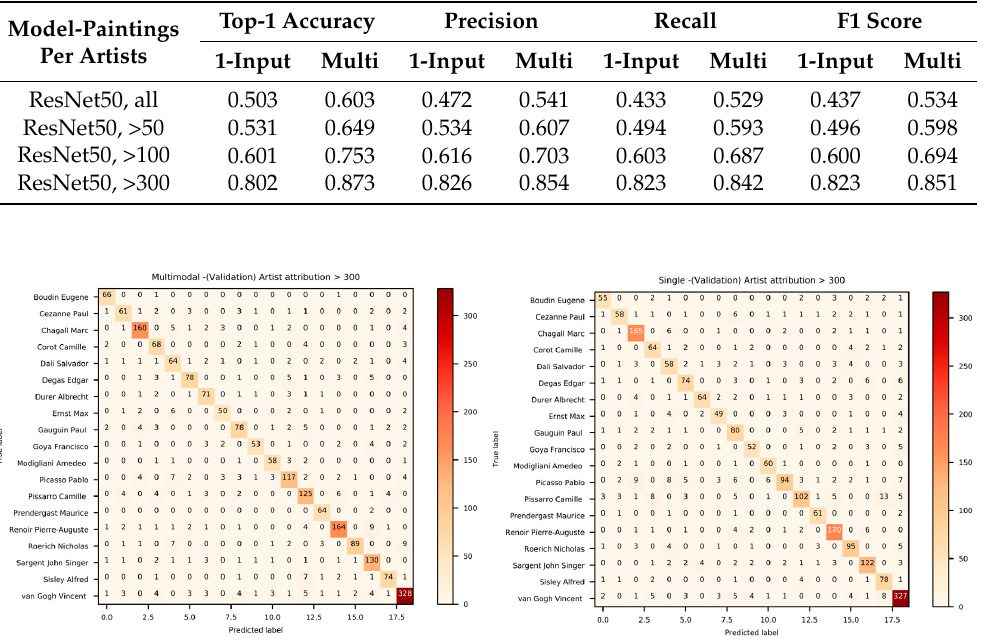
Figure 11. Confusion matrices of the multimodal input ( left ) and single-input ( right ) methods for the artist attribution task of the >300 dataset.